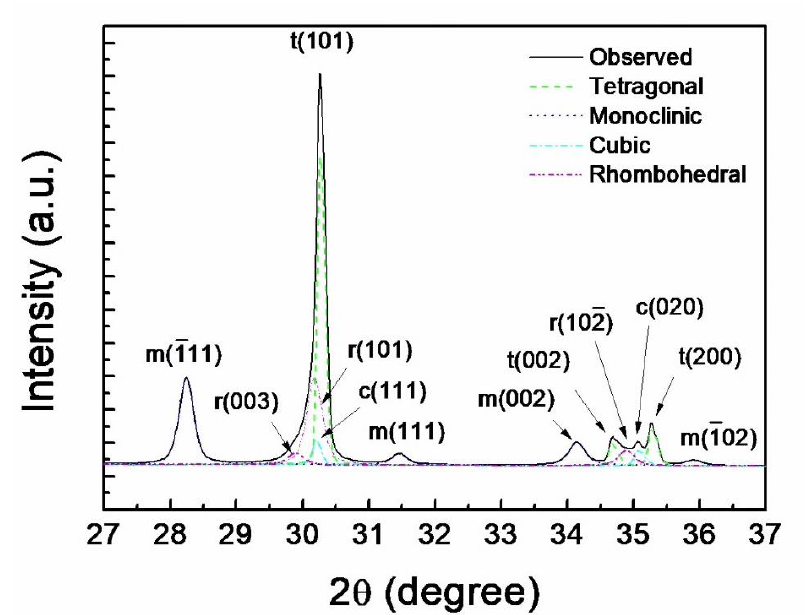
Figure 3. Deconvolution of asymmetric (101) peak of t-ZrO 2 into (003) and (101) peaks of r-ZrO 2 and (111) peak of c-ZrO 2 from 3Y-TZP sintered for 20 h at 1550 °C. The overlapping becomes more evident at 2 θ of ~35° where r(102 ) and c(020) are separated from t(002) and t(200). No overlapping for m-ZrO 2 is observed.